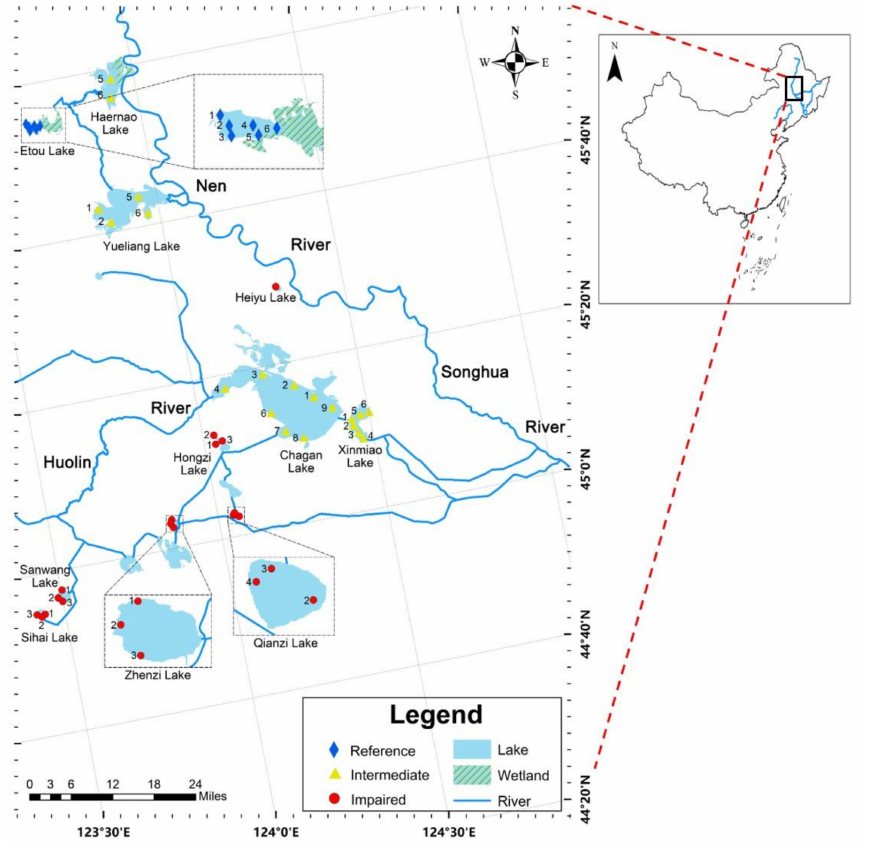
Figure 1. The study region location and sampling sites: the rhombus represents the reference lake sampling sites; the triangles represent the intermediately impaired lake sampling sites; the points represent the impaired lake sampling sites. The number beside the sampling sites represents the serial number of that point in the